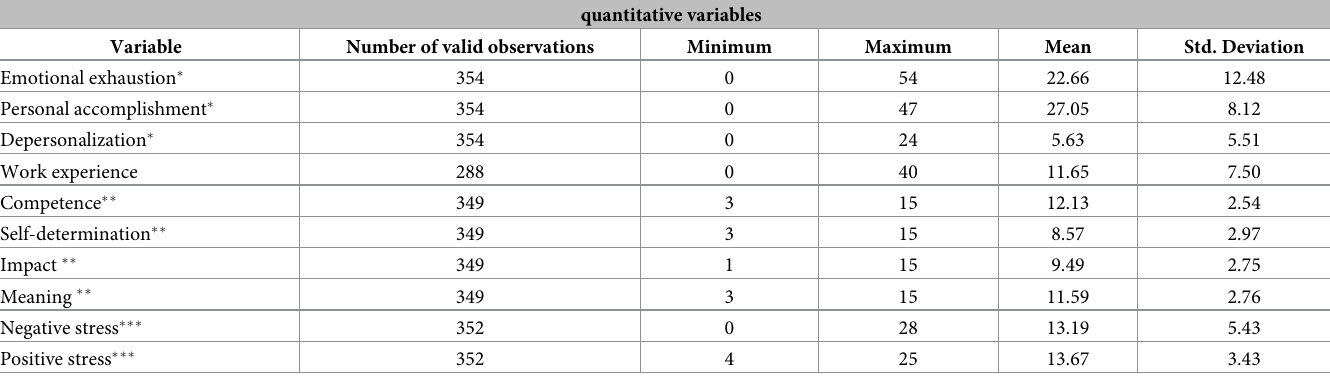
Table 3. Common descriptive statistics for quantitative variables (n =